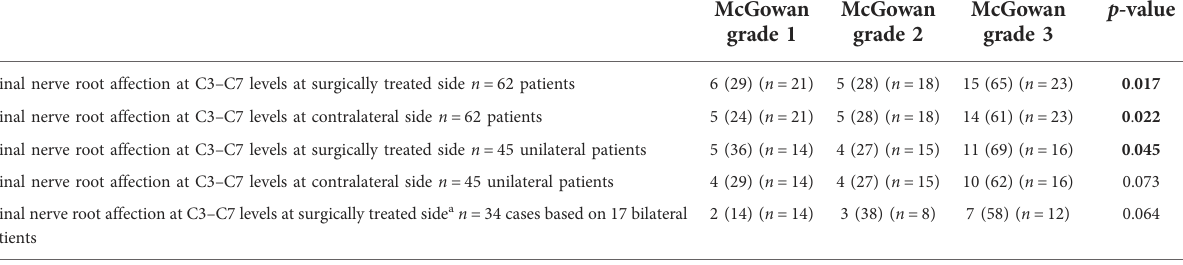
TABLE 5 McGowan grading and spinal nerve root affection in patients with surgically treated ulnar nerve compression at the